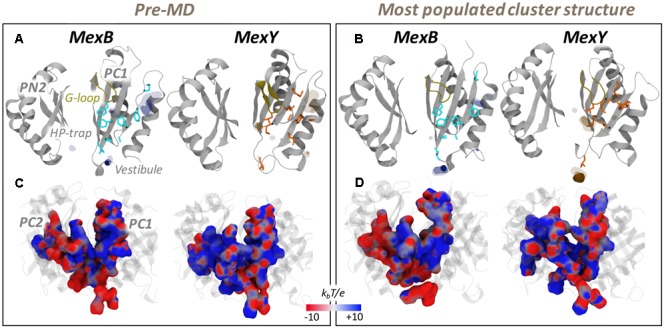
MLP and electrostatic potential of APL of MexB and MexY. (Upper panel) MLP isosurfaces observed within 4 Å of APL of MexB (blue) and MexY (orange) in pre-MD (A) and the representatives of the most populated cluster (B) as seen from the center of the protomer. The hydrophobic/aromatic residues are shown as sticks in the structures. Isosurfaces at 0.75 (solid), 0.5 (dark transparent), and 0.25 (light transparent) are shown in blue (MexB) or orange (MexY). The HP-trap and Vestibule sites are also labeled in the pre-MD structure of MexB. The G-loop is shown in yellow cartoon. (Lower panel) The electrostatic potential plotted on the molecular surface representation of APL in the pre-MD (C) and the most populated cluster representative (D) of the Mex proteins as seen from the periplasmic front of the protomer. The color code is red to blue from negative (-10 kbT/e) to positive (+10 kbT/e) potential, where kb is the Boltzmann constant, T is the absolute temperature and e is the electron charge.